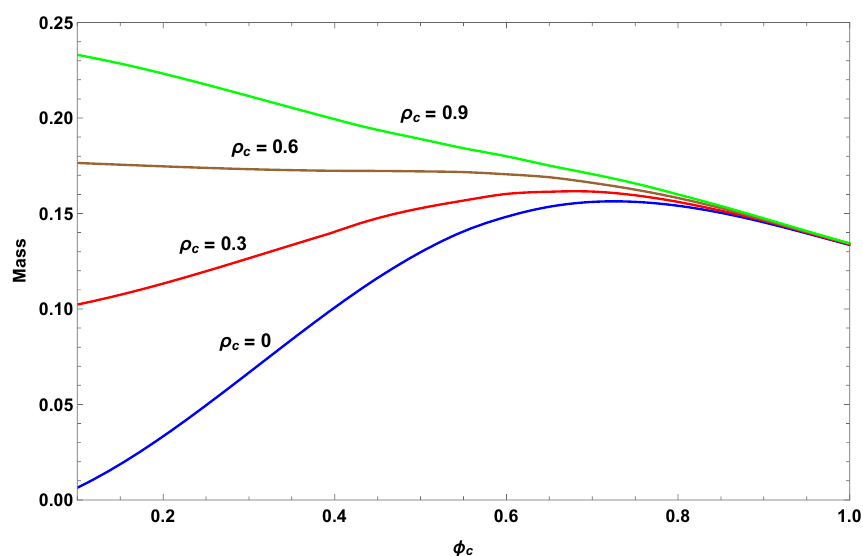
Figure 2. Mass of the spacetime as a function of (cid:30) c and (cid:26) c